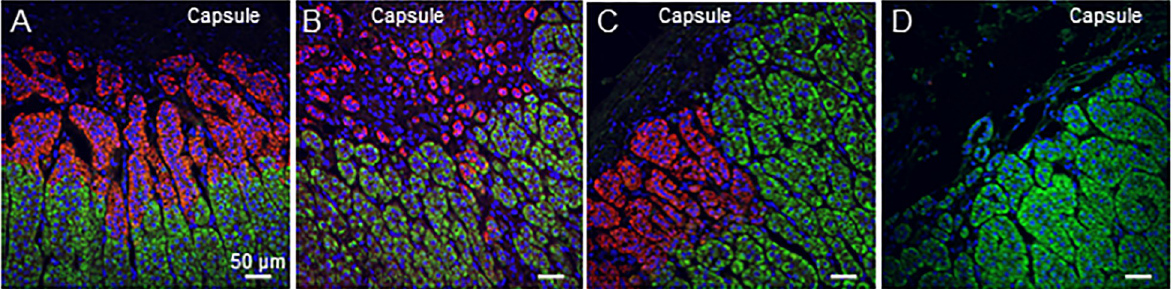
Fig 2. Co-immunofluorescence of CYP11B1 and CYP11B2 demonstrates adrenal remodelling. Illustrative merge photographs of CYP11B2 (red) and CYP11B1 (green) combined with nuclear staining with DAPI (blue) showing that the pattern of expression of the steroidogenic enzymes does not support the zonation defined by histological criteria in the adrenal cortex of a 68-year-old woman (A-D).